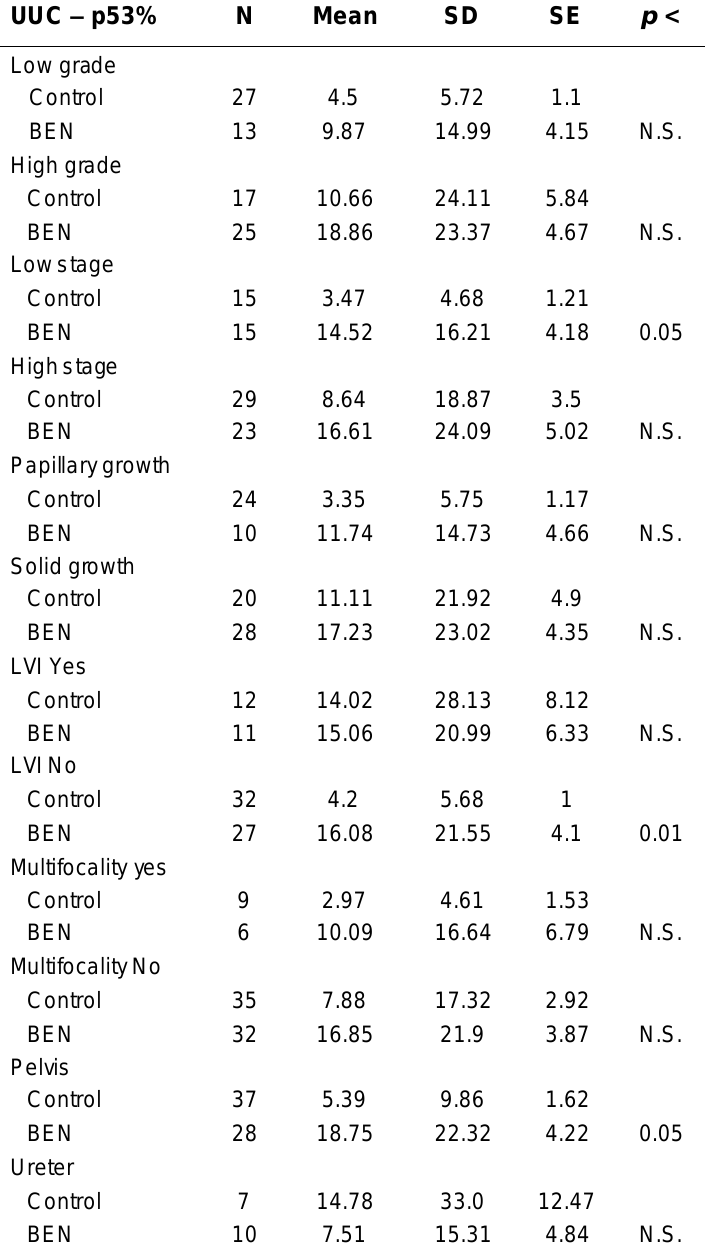
Pathological Variables of UUC and p53 Index in Control and BEN